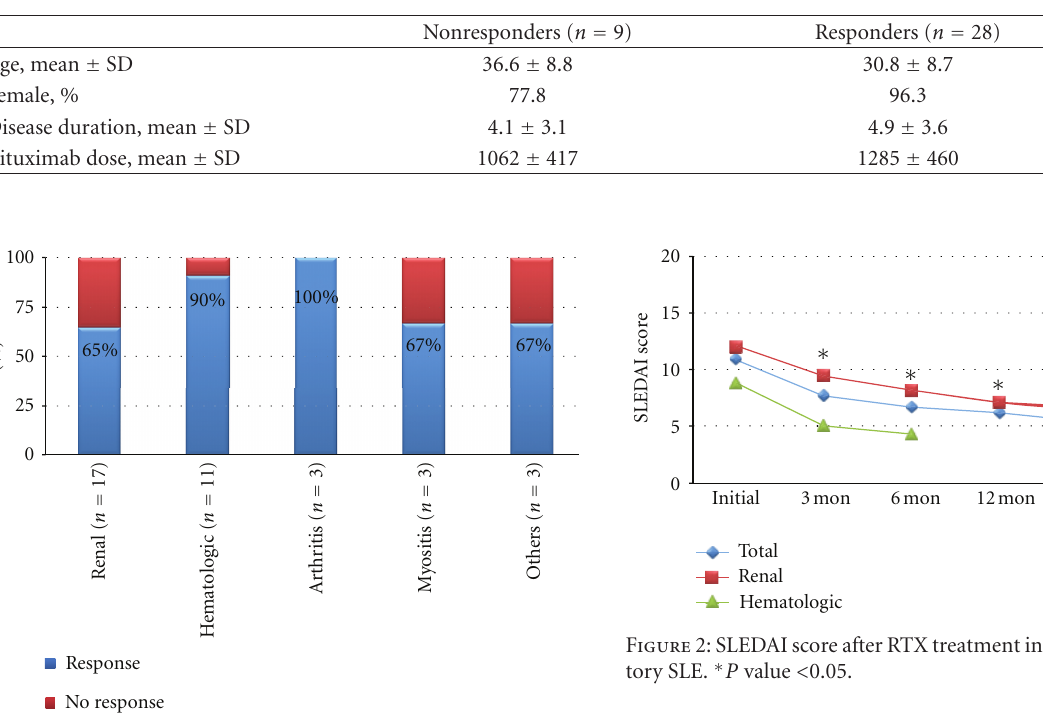
Table 2: Comparison of responders and nonresponders at 6 months after rituximab administration ( n = 37).